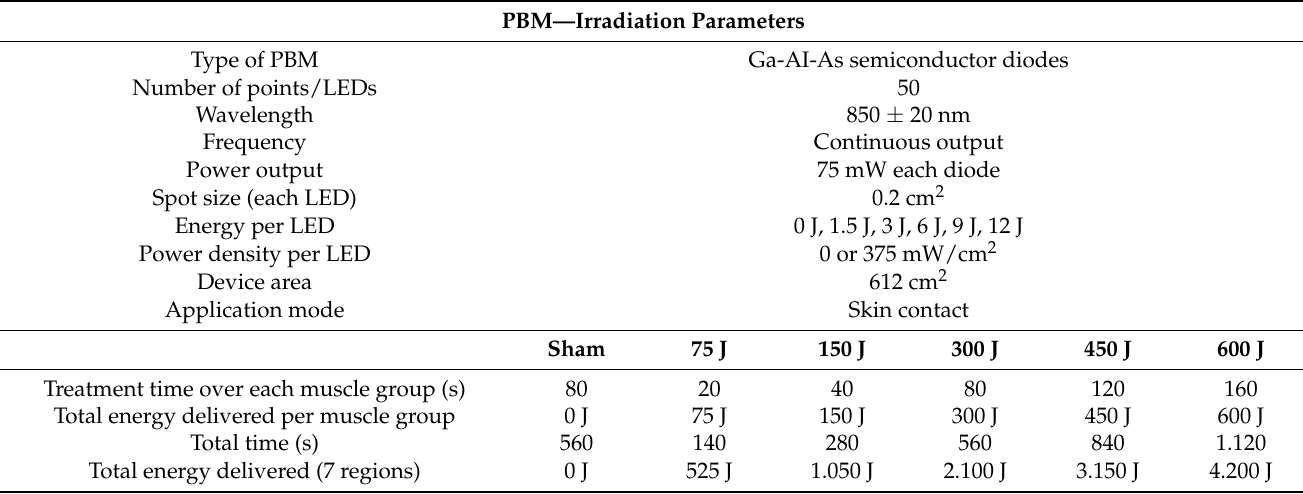
Table 1. Photobiomodulation parameters and application sites.